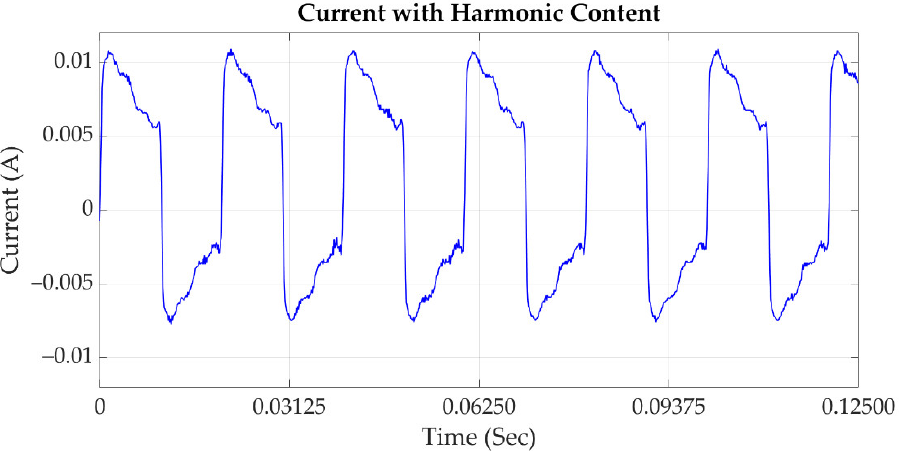
Figure 4. Current signal with harmonic content.